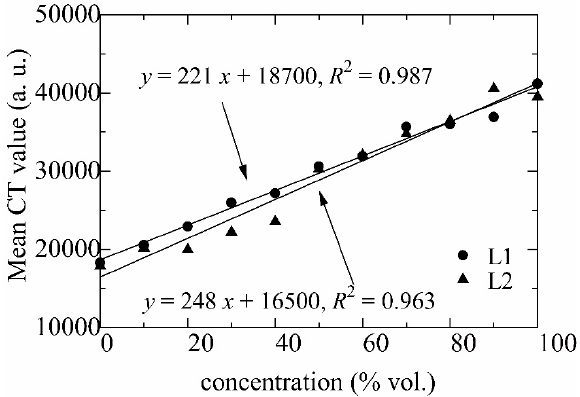
Figure 2. Calibration curves between the concentration of LVF and X-ray computer tomography (CT) value.